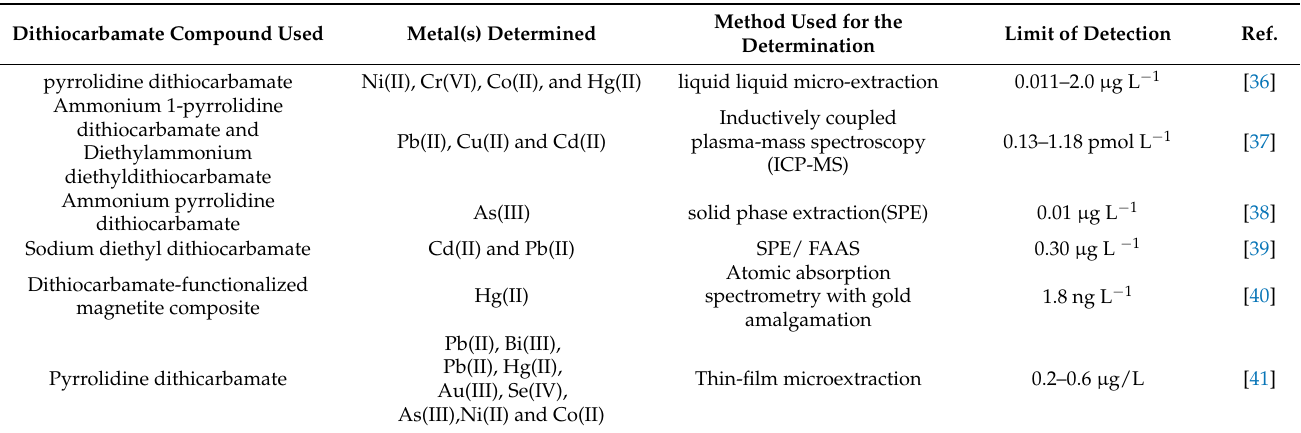
Table 2. Determination of trace elements using